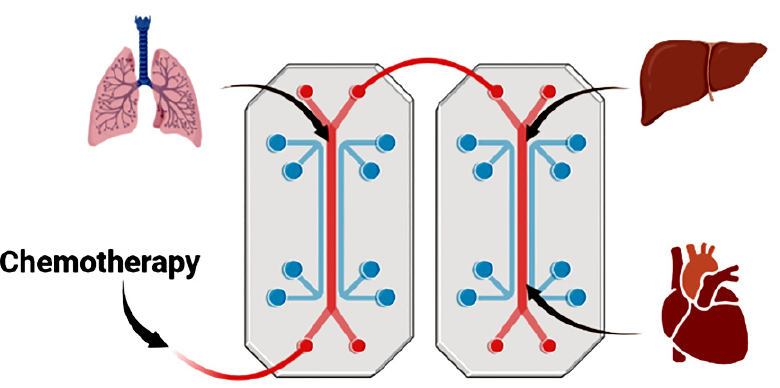
Figure 3. Schematic representation of organ-in-chip system, in which tissue biopsy from multiple organs is connected by microfluidic channels allowing molecular communication. This creates a model of distal interactions and multi-organ axis. In this instance—a chemotherapy agent can be tested for its effect on lung tissue, while monitoring how secondary messengers interact with liver and lung tissue. Organ-in-chip technology allows detection of the metabolic profile involving multi-organ syndrome due to side effects.